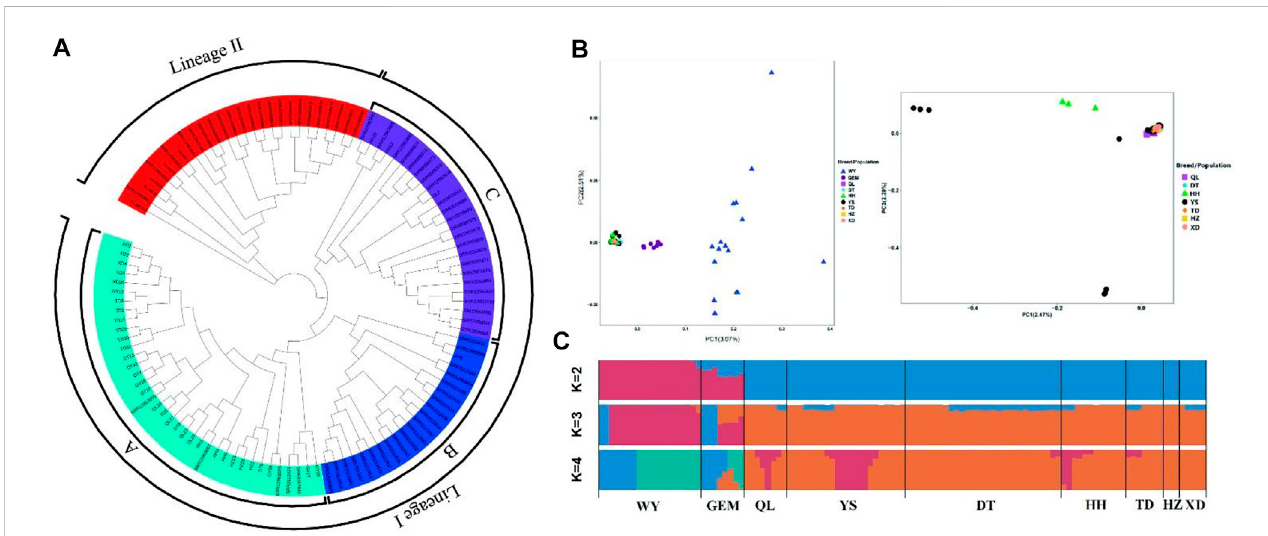
FIGURE 3 Population genetic analyses of Qinghai yak breeds/populations. (A) NJ tree of 113 wild and domestic yak. (B) PCA with fi rst (PC1) and second (PC2) principal components. The right fi gure shows a further PCA excluding wild and Geermu yak populations. (C) Model-based clustering of Qinghai yak breeds/ populations using ADMIXTURE with K = 2 – 4.